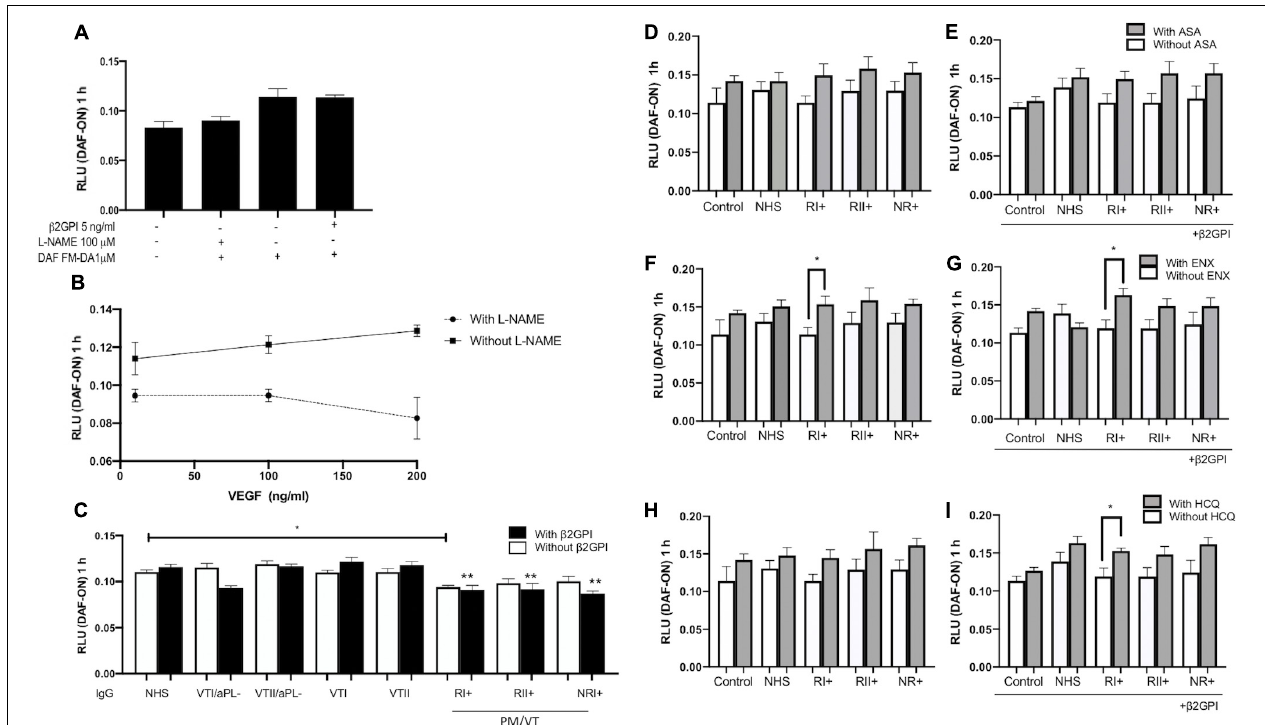
FIGURE 6 | All IgG from patients with pregnancy morbidity and thrombosis (RI+, RII+, and NR+) induced endothelial dysfunction through a decrease in nitric oxide (NO) production in HUVECs. (A) β 2GPI alone did not alter NO production in contrast with the basal control. (A,B) NO release is reduced by the addition of NG-nitro-L-arginine methyl ester (L-NAME). (B) Vascular endothelial growth factor (VEGF) induced NO production in a dose-dependent manner in contrast with cells treated with L-NAME, which exerted its antagonistic effect. (C) IgG/RI+ decreased NO bioavailability in contrast with the IgG/NHS control without β 2GPI. All IgG from patients with pregnancy morbidity and thrombosis (RI+, RII+, and NR+) plus β 2GPI reduced NO production compared with the IgG/NHS control (** p < 0.01). A two-way ANOVA and the Holm–Sidak post-test (* p < 0.05) were performed. (D,E) Aspirin (ASA) had no modulatory effect on the reduction of NO induced by IgG. (F,G) Enoxaparin (ENX) restored NO bioavailability reduced by IgG/RI+ with and without β 2GPI. (H,I) Hydroxychloroquine (HCQ) restored NO bioavailability reduced by IgG/RI+ with β 2GPI. A t -test (* p < 0.05) was performed in ASA and EXN analyses. The HCQ data were analyzed using the Mann–Whitney test (* p < 0.05). The results were obtained from four independent experiments. PM/VT, pregnancy morbidity and vascular thrombosis.